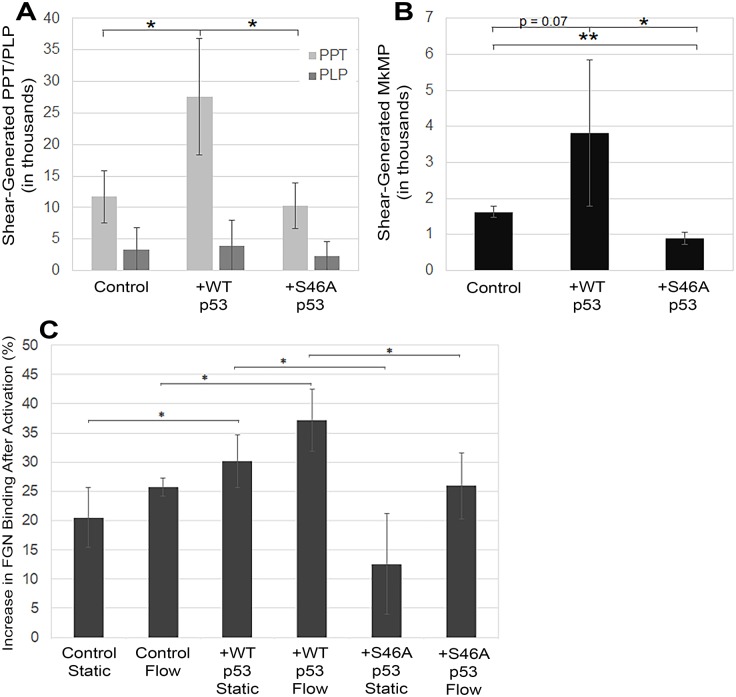
Shear-stimulated Mk particle biogenesis is dependent upon transcription-independent p53-induced apoptosis.A, Number of PPTs and PLPs generated by shear-flow exposure from wild-type, p53-overexpression, and p53-S46A Mks. Particle numbers were normalized per 100,000 Mks. Unpaired t-test, *p < 0.05, n = 3 (biological replicates), error bars: SD. B, Number of MkMPs generated following shear-flow exposure by wild-type, p53-overexpression, and p53-S46A Mks. MkMP numbers were normalized per 100,000 Mks. Unpaired t-test, *p < 0.05, ***p < 0.001, n = 3 (biological replicates), error bars: SD. C, Percent of PLPs from wild-type (WT), p53-overexpression (OE), and p53-S46A (d46) Mks that are bound to fibrinogen (FGN) following activation with 3 units of thrombin. Unpaired t-test, *p < 0.05, n = 3 (biological replicates), error bars: SD.